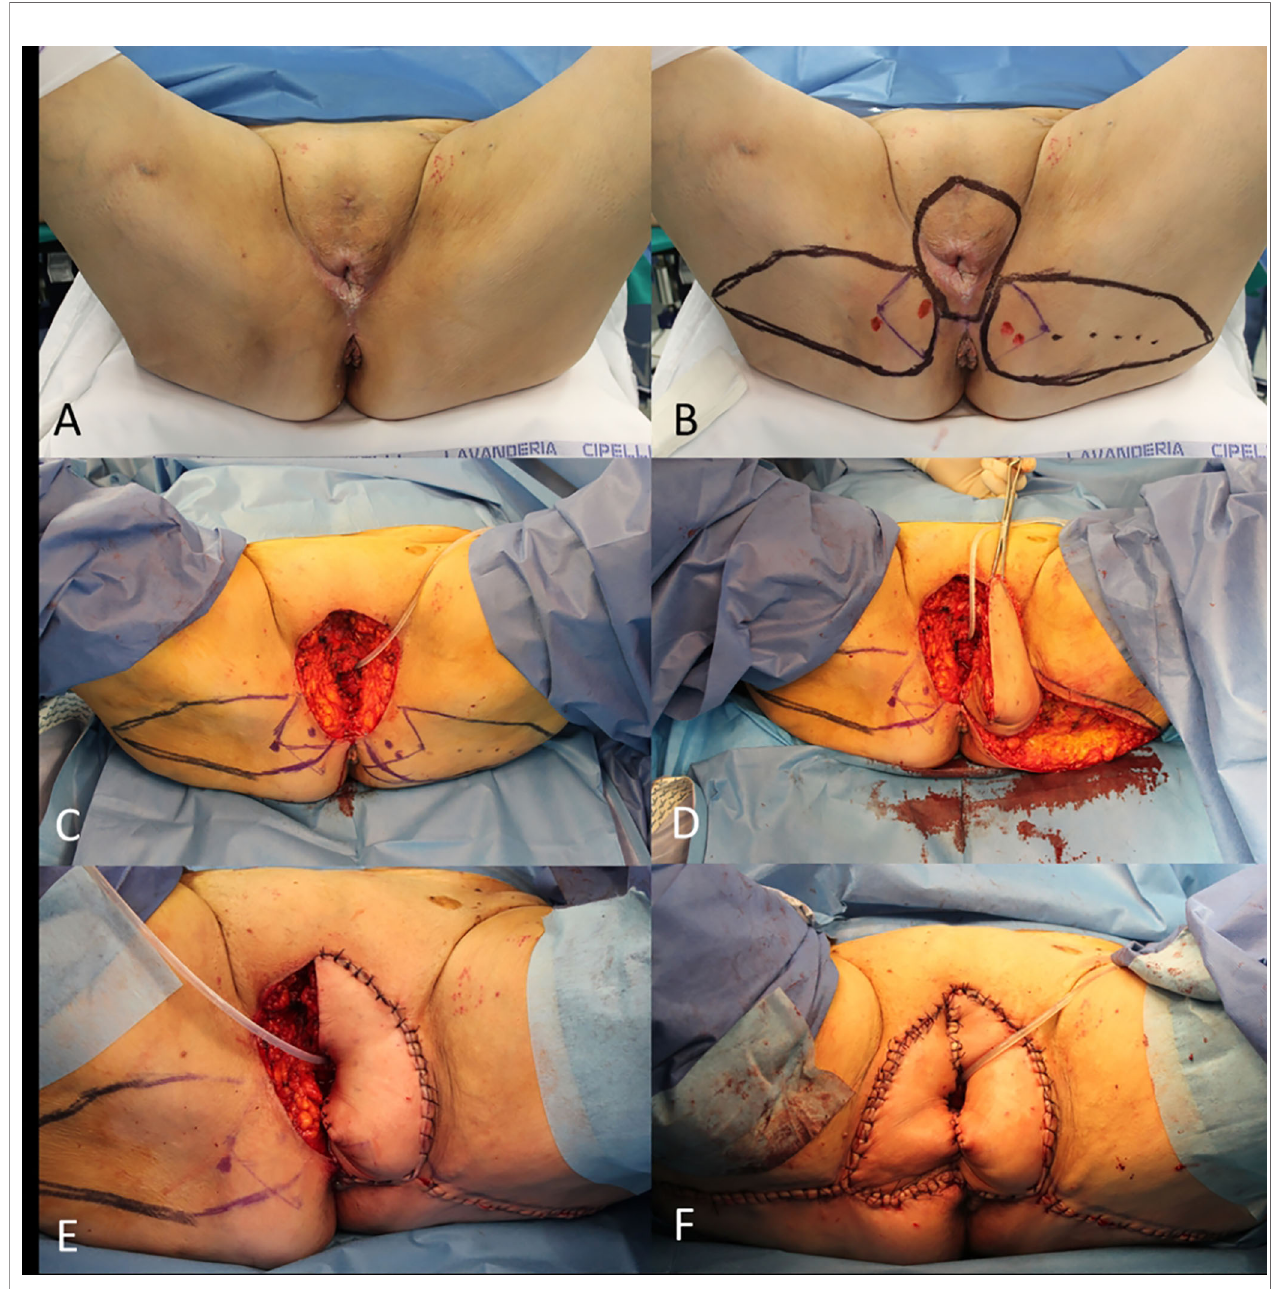
FIGURE 10 | (A) Recurrent cSCC of the vulva; (B) Planning of the radical vulvectomy and bilateral perforator (lotus) fl aps; (C) End of the vulvectomy; (D) Rotation of the left perforator fl ap; (E) Left lotus fl ap insetting; (F) Final